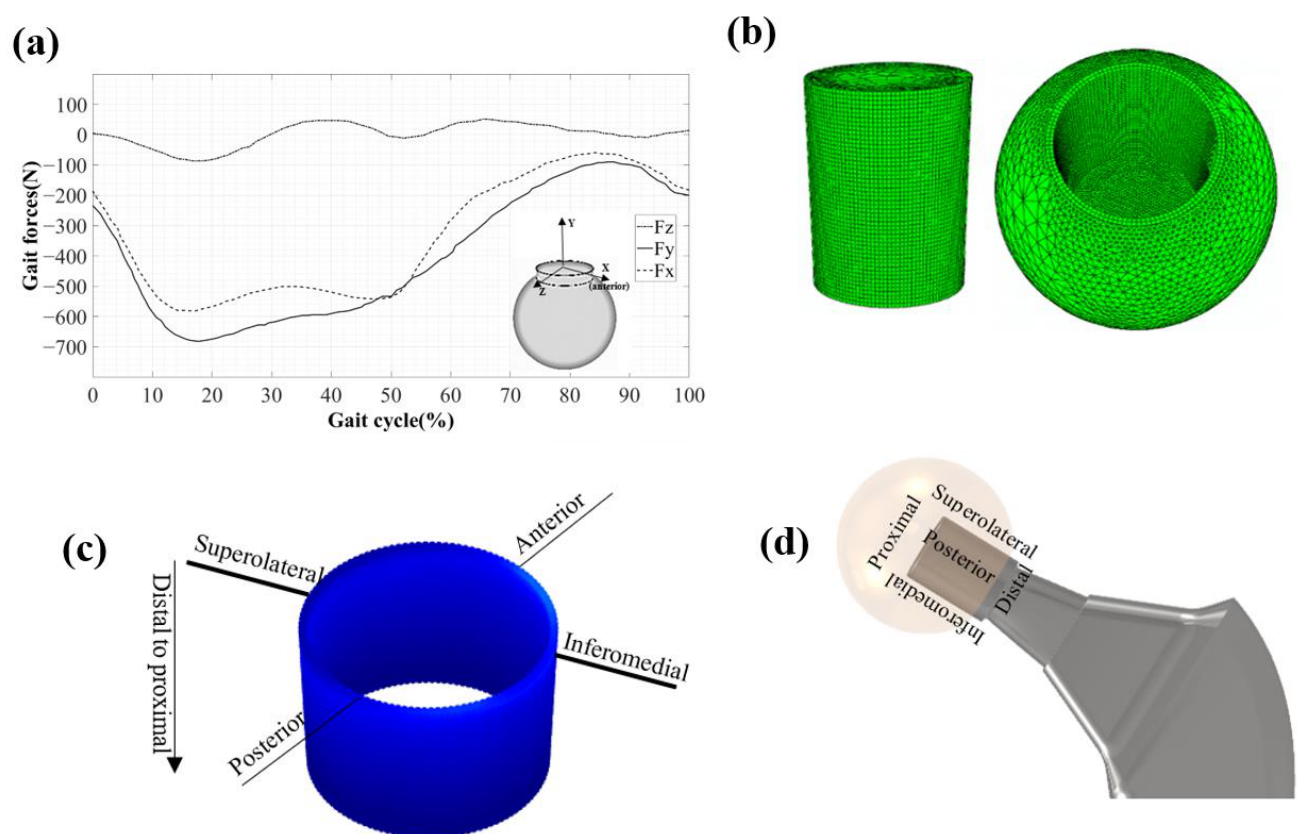
Figure 2. ( a ) Gait force profiles; ( b ) Meshing structure of the head-neck FE model; ( c ) Different regions in the head and neck surfaces; ( d ) Schematic view of the head-neck junction of a hip implant. 2.3. The Method of Comparing FE Predicted Tribocorrosive Wear Profiles with Damage Patterns in Retrieved